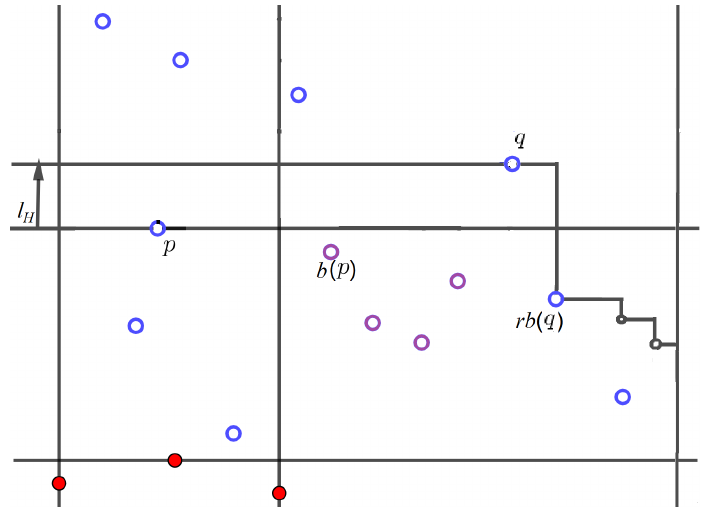
Figure 7. Case 4. p ∈ B N , q is to the right of b ( p ) . The purple empty dots denote U ( q ) . Case 5. If q ∈ B NE and q is to the left of b ( p ) , then, if t = k NNE − 1, we add ( q , s ) to S t + 1 for every ( p , s ) ∈ S t (Figure 8).